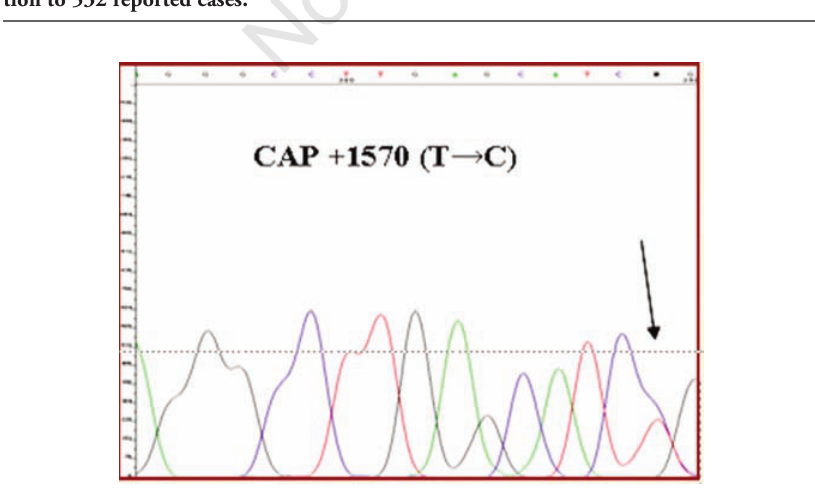
Figure 3. Distribution of the 27 identified nucleotide changes in the β -globin gene in rela- tion to 532 reported cases.